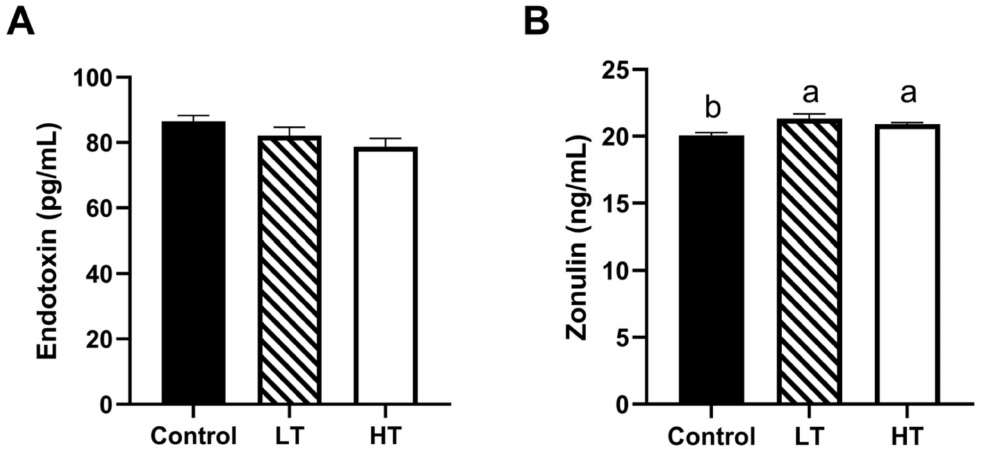
Figure 2. Effect of TA on the intestinal permeability of Brandt’s voles. Plasma levels of endotoxin ( A ) and zonulin ( B ). Control, 0 mg • kg − 1 d − 1 TA; LT, 600 mg • kg − 1 d − 1 TA; HT, 1200 mg • kg − 1 d − 1 TA; a, b Means with different letters differ significantly ( p < 0.05). Data are presented as mean ± SEM, n =